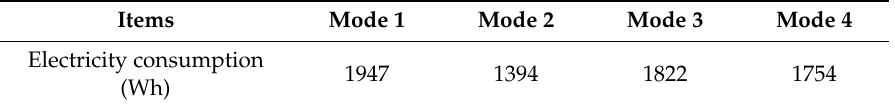
Table 5. Energy consumption after 90 min.